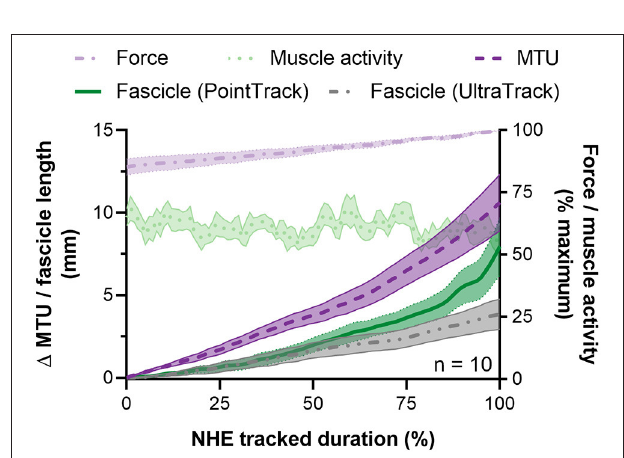
FIGURE 5 | Mean ± SEM left-sided biceps femoris long head (BF) fascicle length and muscle-tendon unit (MTU) length changes (left y-axis) and normalized external reaction forces and BF EMG root-mean-square amplitudes (right y-axis) during the Nordic hamstring exercise (NHE) from 85 to 100% of peak force. Due to the different durations that fascicle lengths were tracked up until peak force, all data from one NHE trial across participants were time normalized to 100 data points and averaged. Fascicle length changes determined from the two tracking algorithms described in the Materials and Methods section are